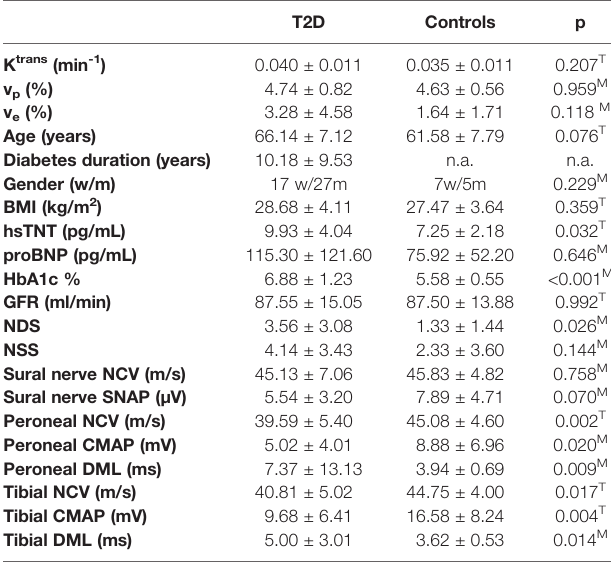
TABLE 1 | Comparison of demographic, serologic, clinical, electrophysiological, and MRN imaging data of all study participants. T2D